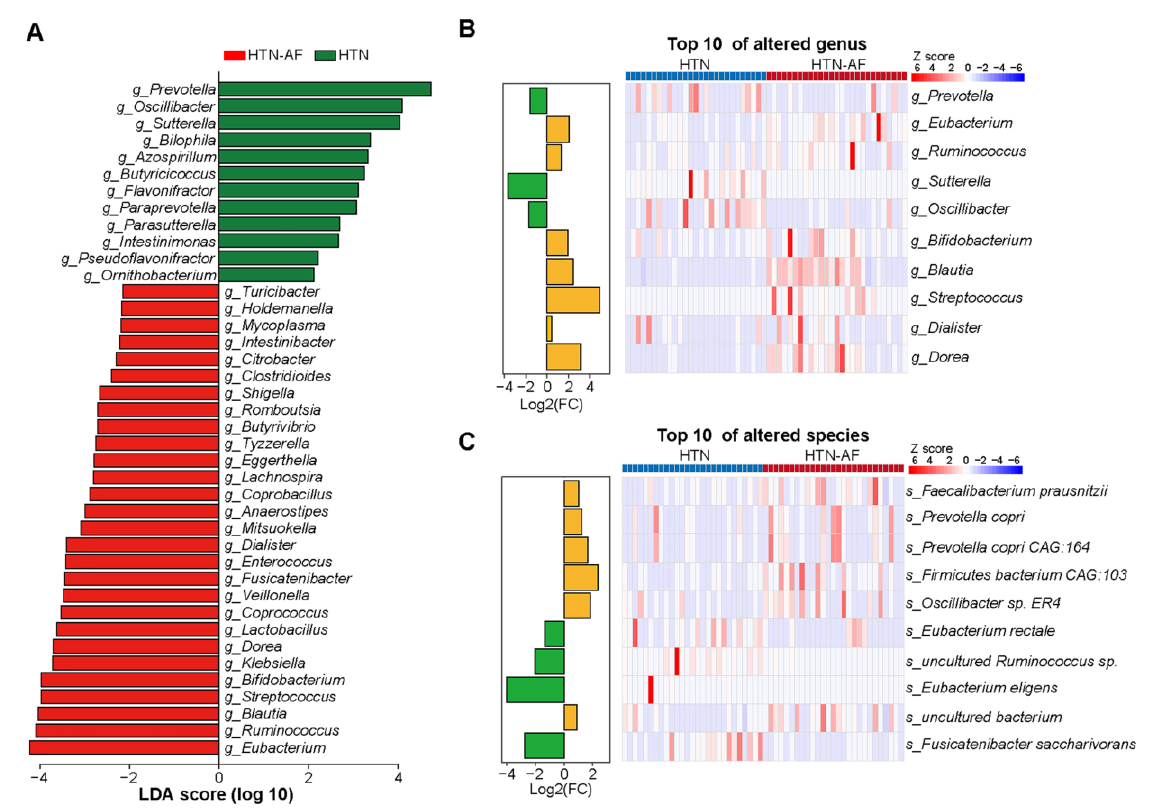
Figure 3. Differential GM compositions between HTN and HTN-AF patients. ( A ) Histogram of linear discriminant analysis (LDA) combined with effect size (LEfSe) analysis with absolute LDA scores (log 10) > 2 and p values < 0.05. ( B , C ) Histogram and heat map illustrating the log2 fold-change (HTN-AF/HTN) and relative abundance of the top 10 significantly altered genus ( B ), and species ( C ) in HTN and HTN-AF groups, respectively.